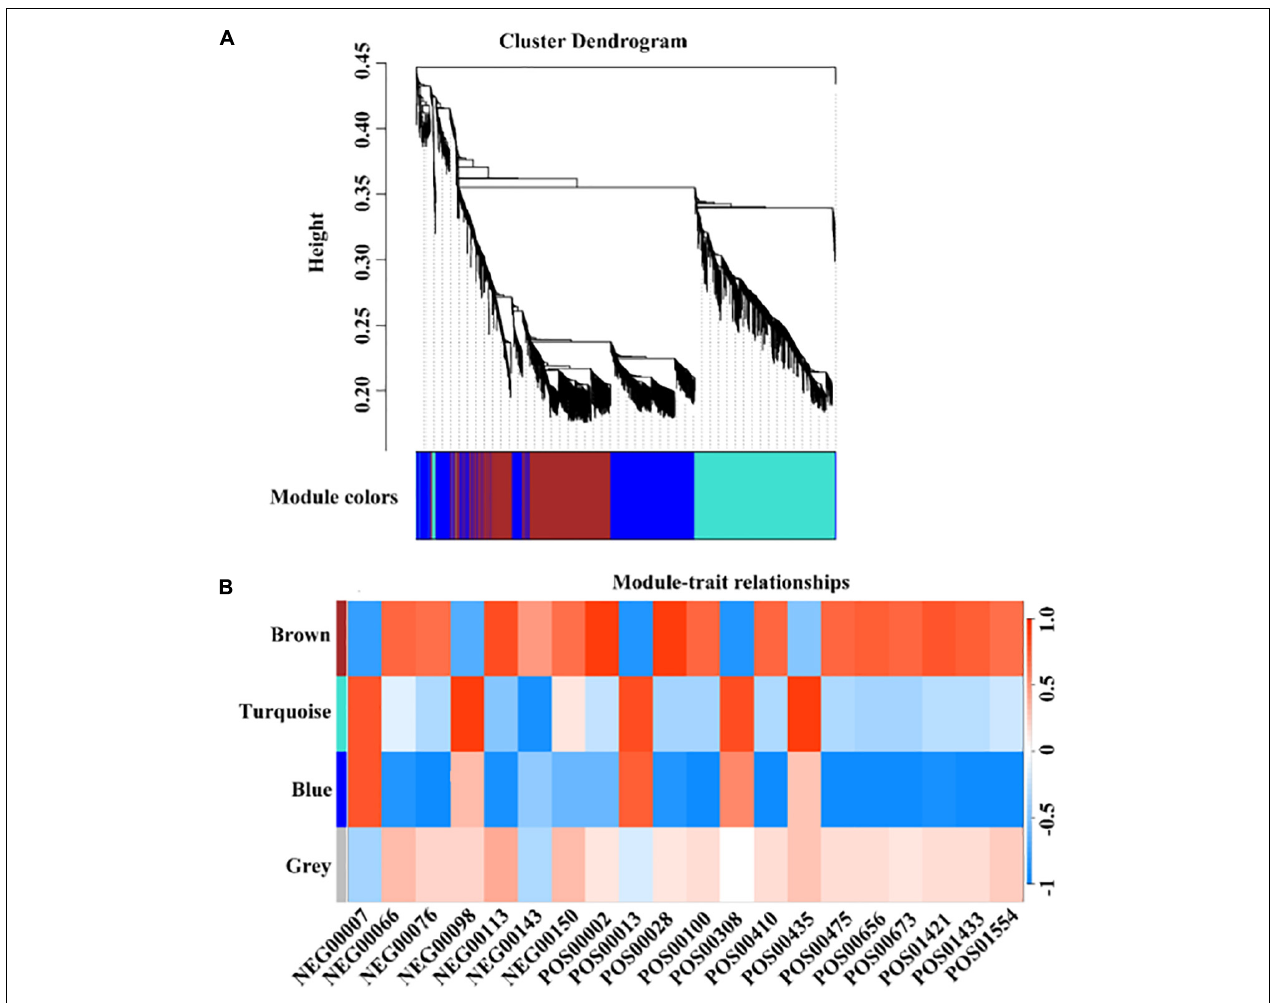
FIGURE 7 | WGCNA analysis of early maturation-related genes and metabolites. (A) The colors of each block indicate the correlation coefficient between the modules and the traits. (B) The bar on the right represents the range of correlation coefficients between modulus and traits. The redder means the more positive correlation, and the bluer means the more negative